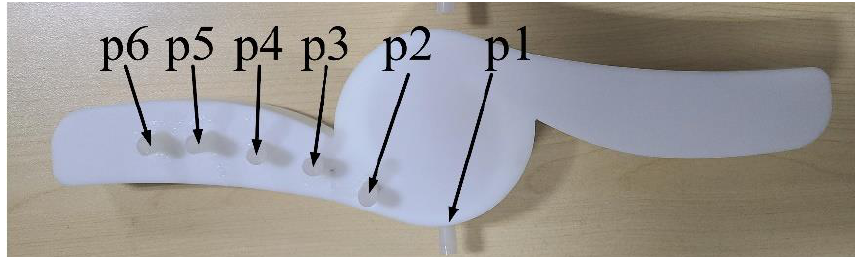
Figure 5. Pressure pulsation monitoring points positions.